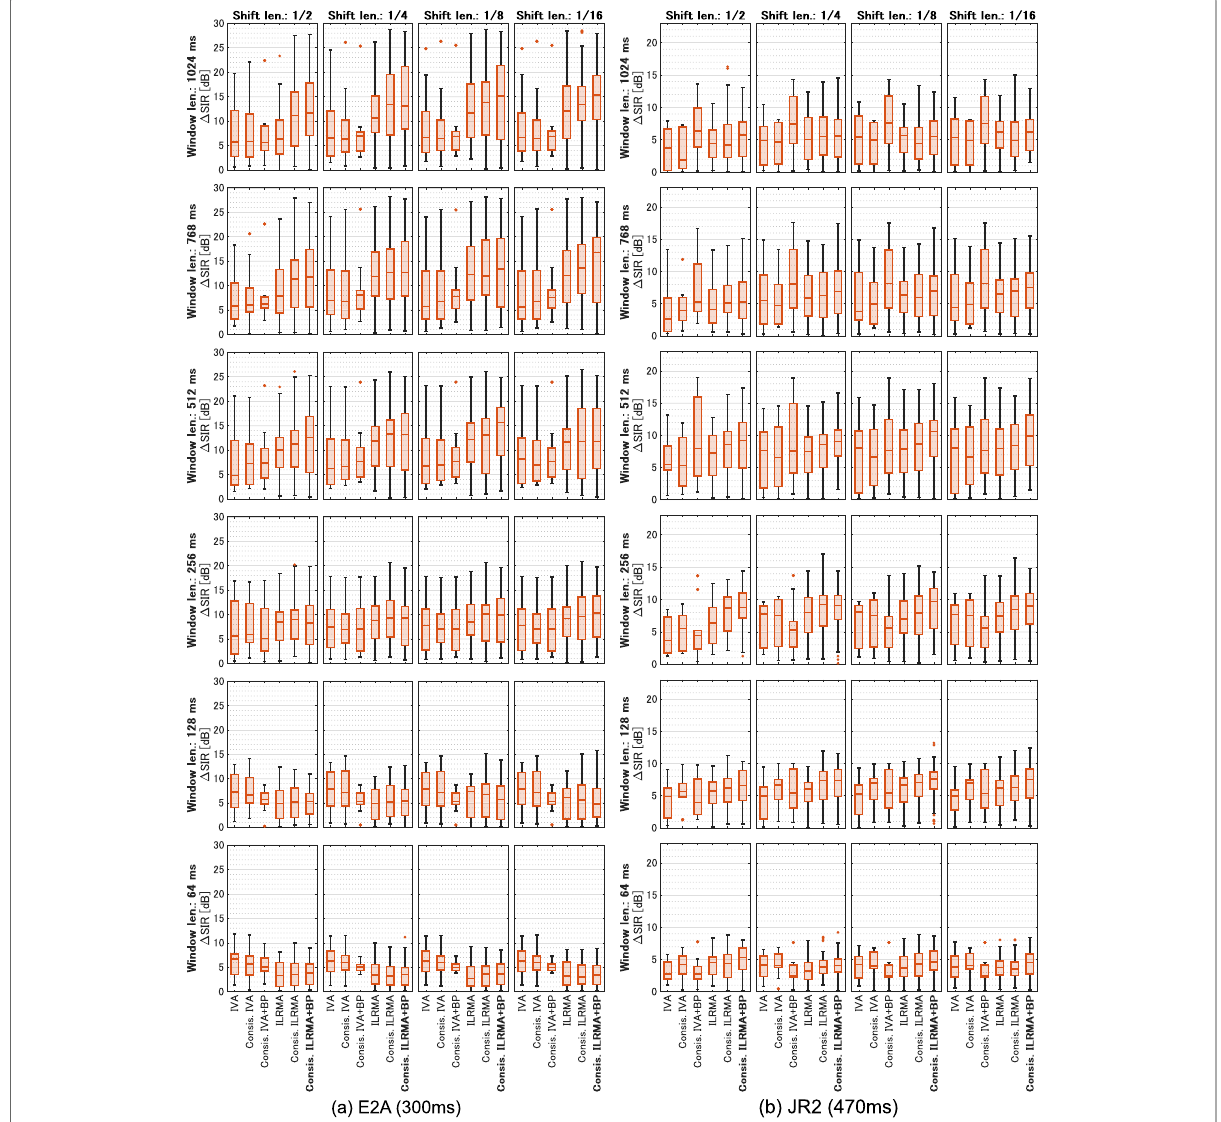
Fig. 20 Average SIR improvements for synthesized speech mixtures (speech 1–10) with a E2A and b JR2 , where Hamming window is used in